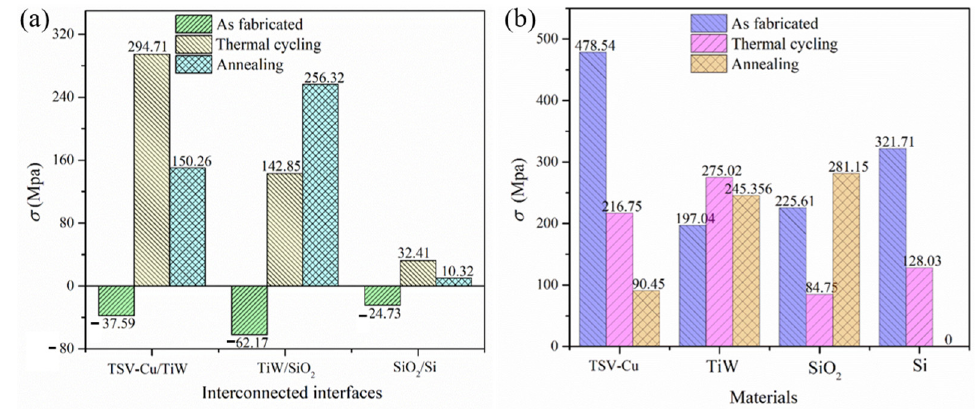
Figure 6. The residual stress at interfaces and inner materials: ( a ) residual stress at interfaces; ( b ) residual stress in inner materials.